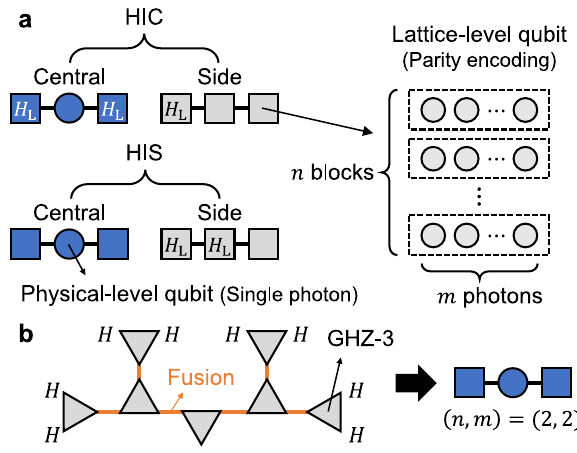
Fig. 4 Structure and generation of post- H microclusters for PTQC. a Schematics of central and side post- H microclusters for PTQC with the HIC and HIS con fi gurations. The marks “ H L ” indicate the locations of the lattice-level Hadamard gates. b Example of a process generating a post- H microcluster from GHZ-3 states. Each GHZ-3 state is represented by a triangle whose vertices indicate its three photons. An orange line connecting two vertices and a mark “ H ” next to a vertex respectively mean a fusion and Hadamard gate performed on the photon(s). The graph of the triangles connected with the orange lines is called a merging